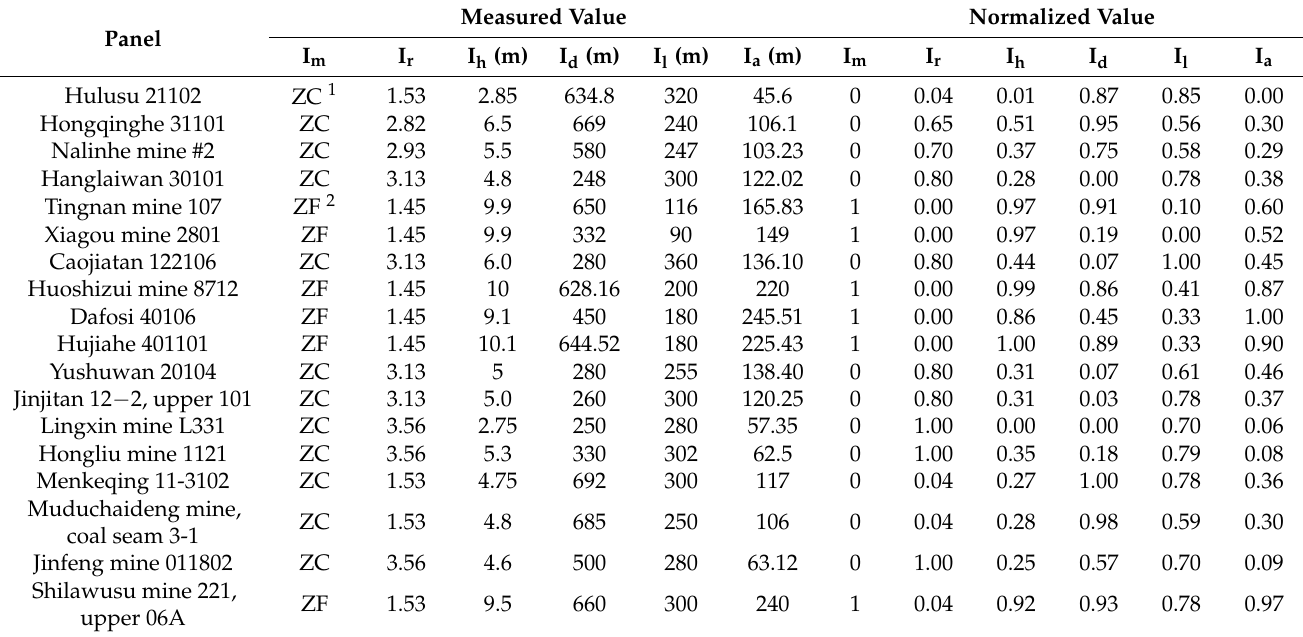
Table 1. Measured values and normalized values of the heights of the